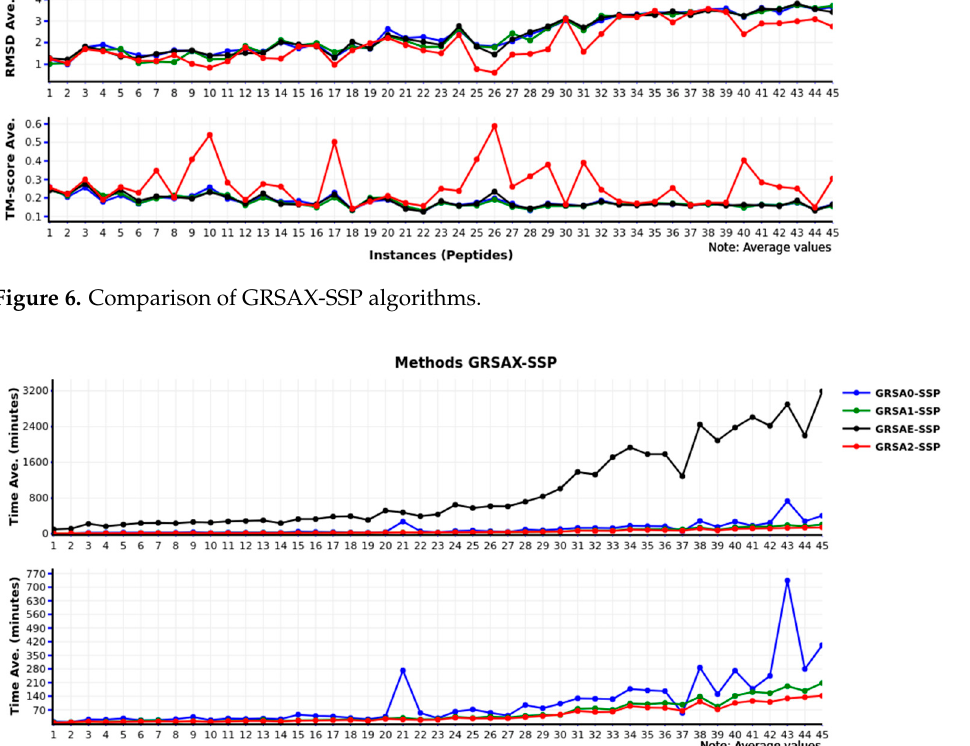
Figure 7. Comparison of the average time of the 30 execution of GRSAX-SSP algorithms.